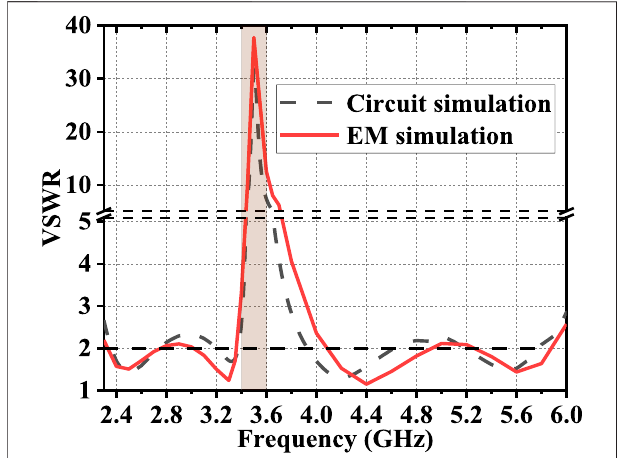
FIGURE 7 | Circuit simulation result of the equivalent circuit, and the EM simulation result of the band-notched antenna.